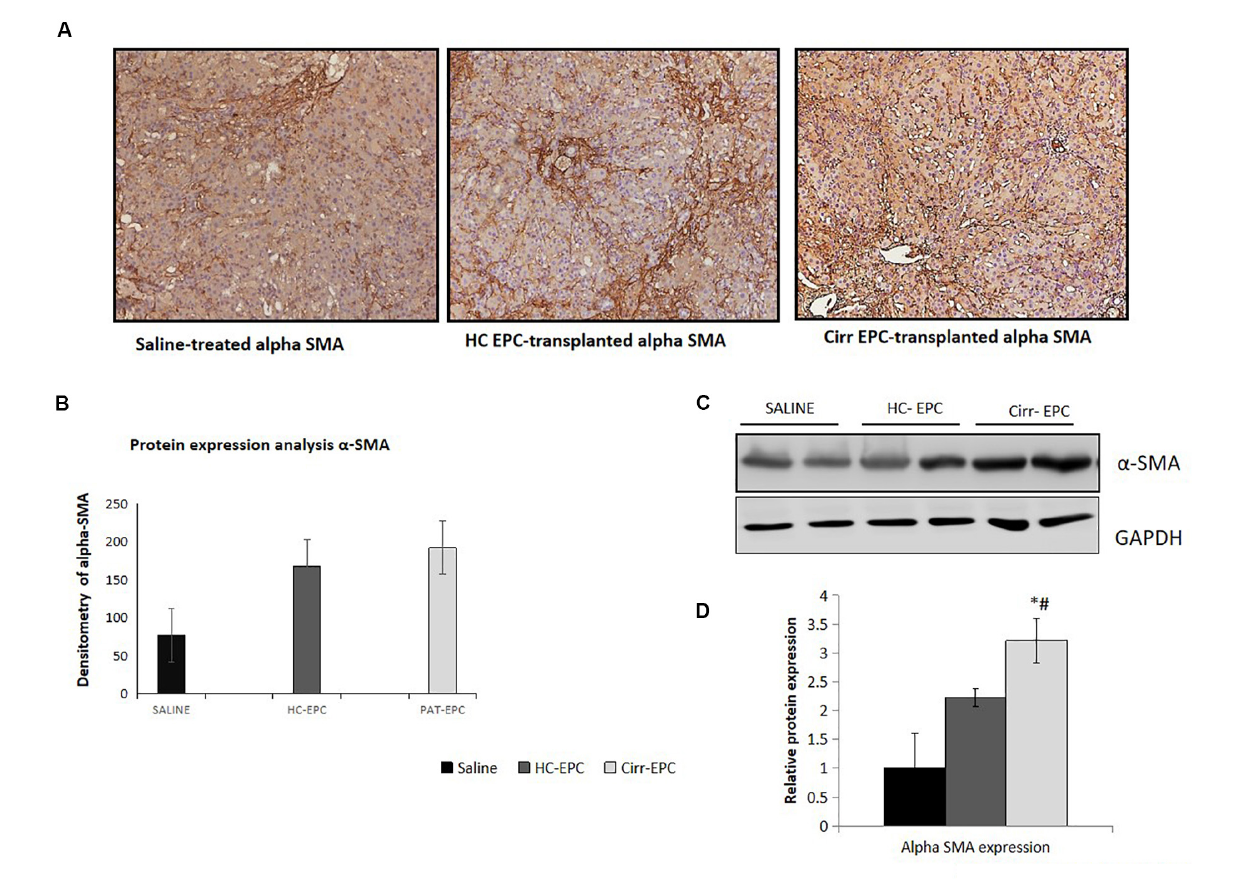
FIGURE 6 | Histochemical staining of liver tissues sections (10x) in saline-treated, healthy control, and cirrhotic EPC-transplanted rats for fibrosis markers. (A) Alpha-SMA, (B) Densitometric analysis of alpha-SMA, (C) Representative western blots of alpha-SMA, and (D) Densitometric analysis of western blots of alpha-SMA in saline-treated, control, and cirrhotic EPC-transplanted rats. * P < 0.05 vs. saline, #, vs. HC-EPC.